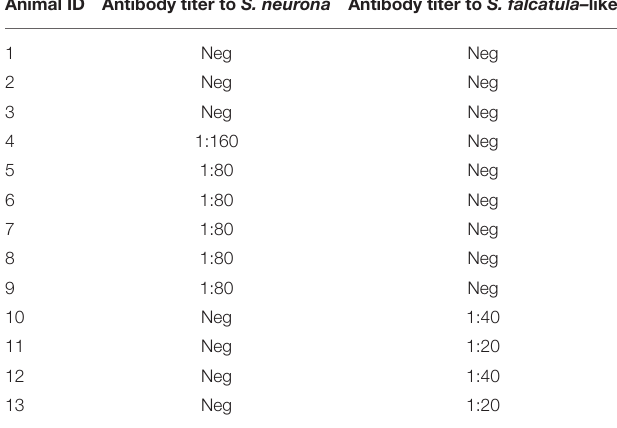
TABLE 2 | Horse sera selected for Western blot and their antibody titers for Sarcocystis neurona and Sarcocystis falcatula determined by IFAT. Animal ID Antibody titer to S. neurona Antibody titer to S. falcatula–